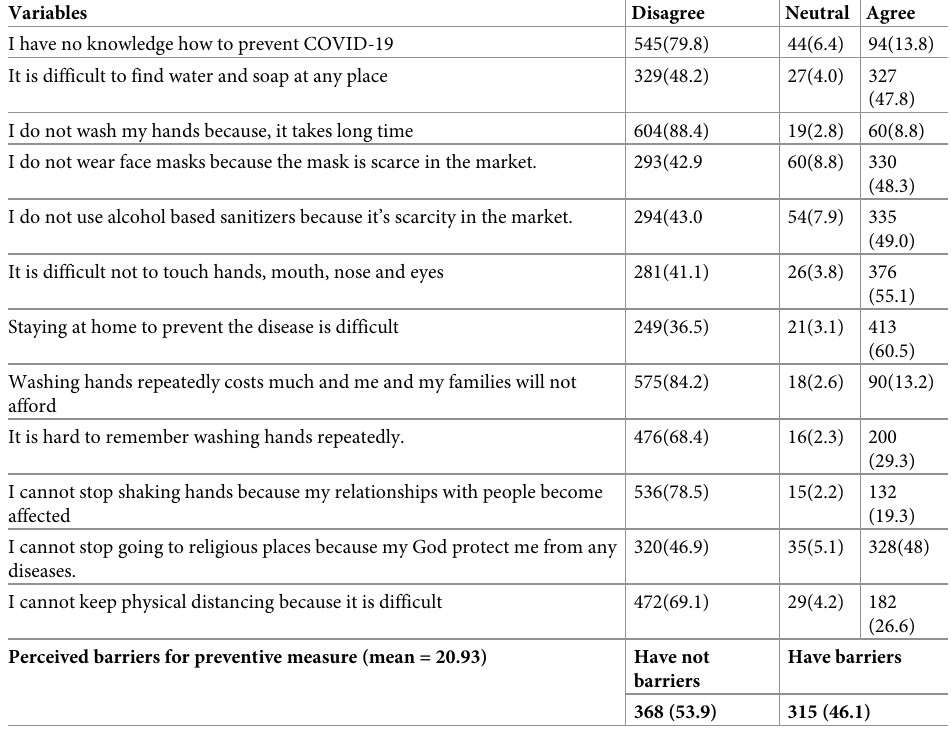
Table 4. The respondents’ perceived barriers of COVID-19 infection prevention in North-shoa zone, Ethiopia, 2020.